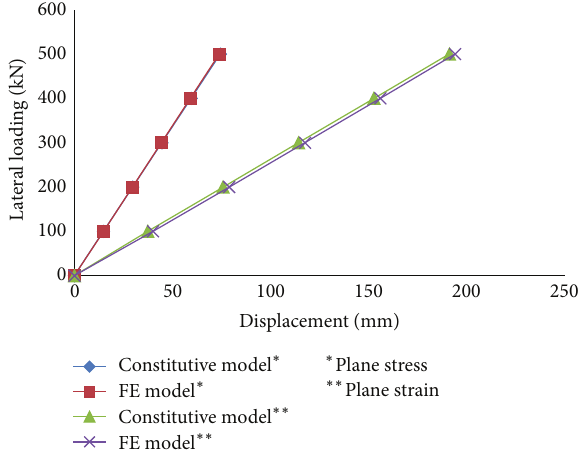
Figure9:Lateralload-deflectionoftheproposedconstitutivemodel and FE model for